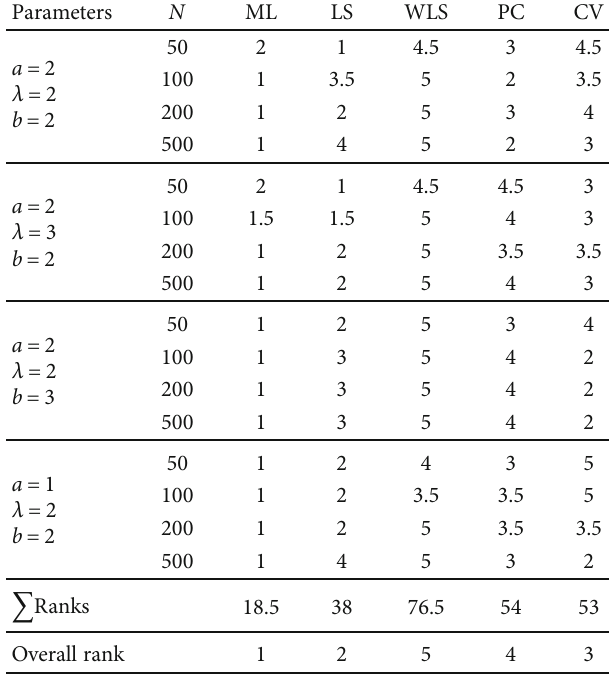
Table 6: Ranks of all the methods of estimation for di ff erent parametric speci fi cations.